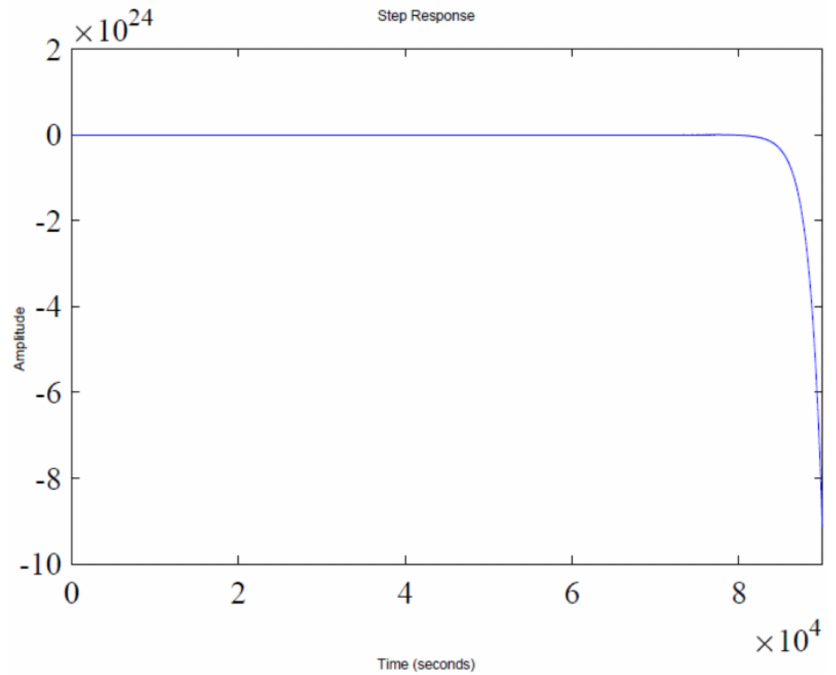
Figure 2. Closed-loop unit step response.